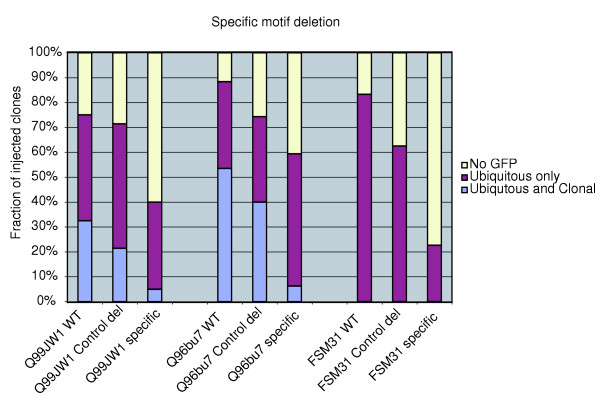
A bar chart summarizing 309 transgenic experiments. Each set of three bars represents a particular construct for a gene, labeled WT (wild type) for unaltered promoters, control del. for the control deletion of a random motif and specific for the specific deletion of the identified motif. In each bar, the proportions of embryos that were classified either as having no expression, ubiquitous only expression or ubiquitous with clonal expression are shown in yellow, maroon and blue, respectively. Each reporter was injected around 30 times and the expression patterns were scored in a double blind manner. GFP, green fluorescent protein.